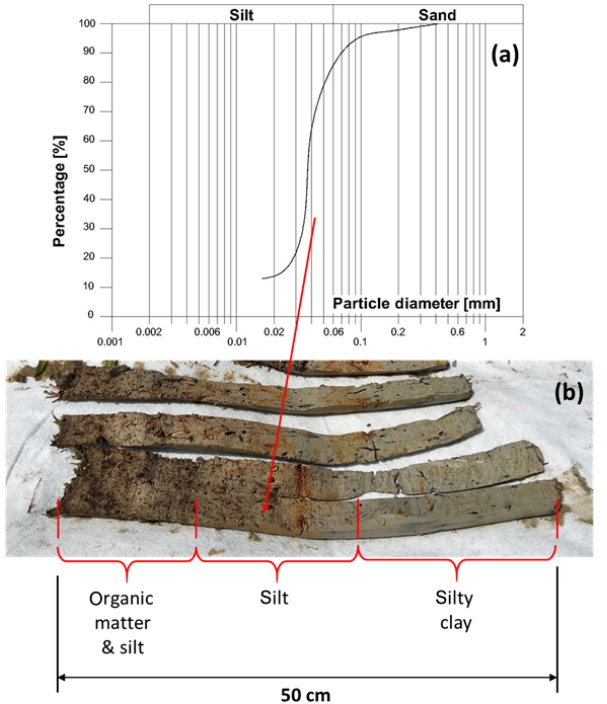
Figure 3. (a) Grain size distribution of a sample collected in the Lazzaretto Nuovo marsh at about 20cm depth. (b) Picture of a 50cm deep core drilled to establish one of the piezometers. The main lithological units are